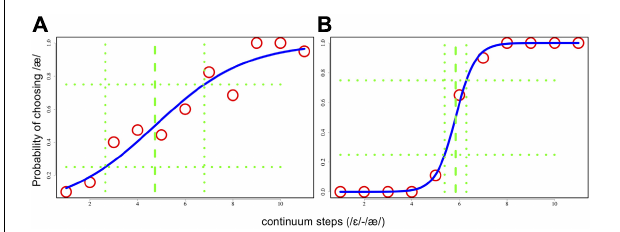
FIGURE 1 | Examples illustrating the categorical labeling consistency measure. (A) A participant with lower consistency. (B) A participant with higher consistency. The center dashed line denotes the categorical boundary. The dotted line to the left of the boundary represents 25% probability. The line to the right of the boundary represents 75% probability.